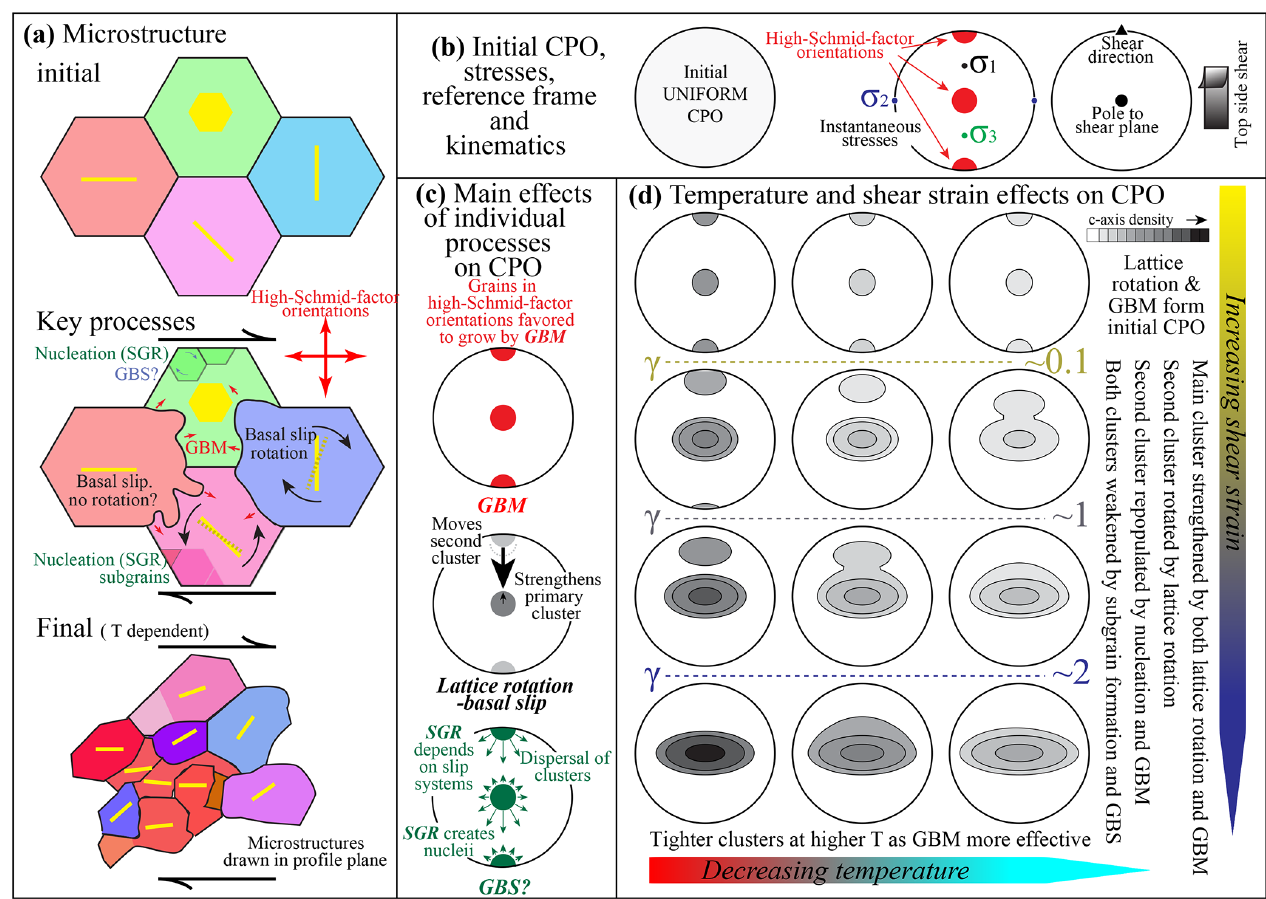
Figure 10. Schematic drawing for the development of CPOs in ice sheared in the laboratory. (a) The evolution of microstructure. Four hexagonal ice grains with different initial orientations of basal planes are used to represent the microstructure. (b) Initial CPO and the kinematics in the shear surface. σ 1 and σ 3 are the maximum and minimum deviatoric stresses (compressive positive), respectively. (c) The effects from CPO-formation mechanisms. (d) The development of CPOs with strain at different temperatures. SGR: subgrain rotation. GBM: grain boundary migration. GBS: grain boundary